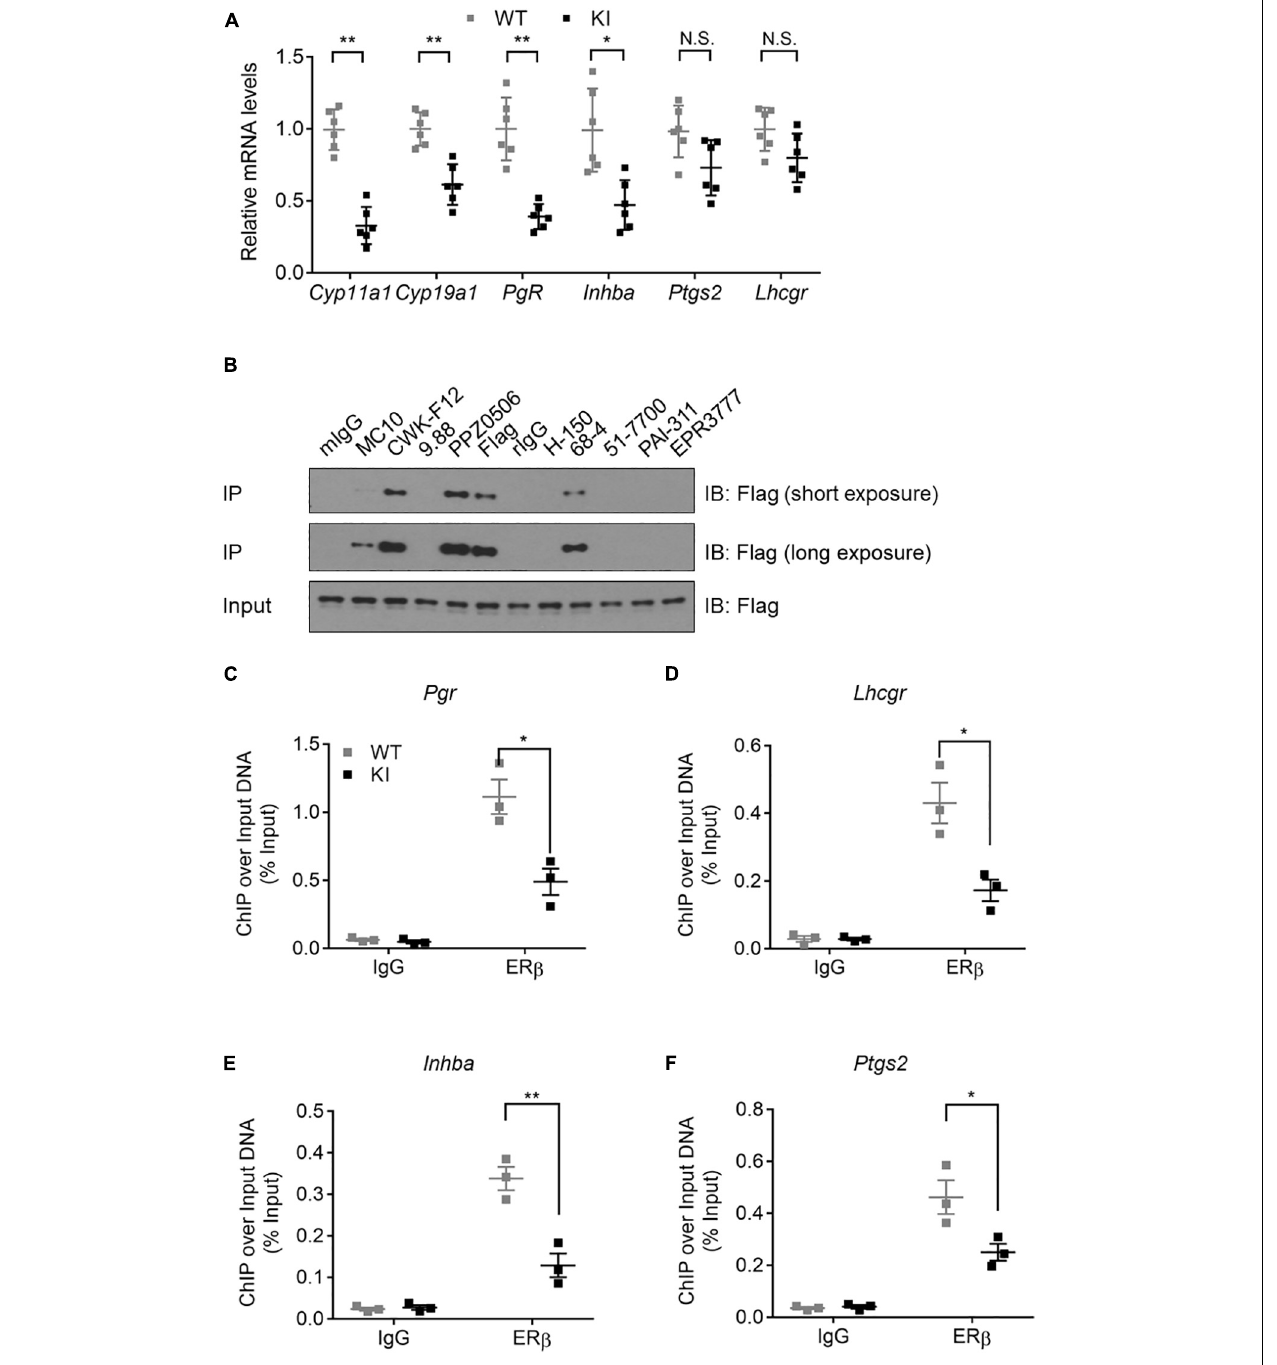
FIGURE 3 | Y55 is important for ER β transcriptional activity in murine ovaries. (A) Levels of mRNA for steroidogenesis genes in the ovaries from WT and KI mice ( n = 6) after superovulation. N.S.: Not Significant, ** p < 0.01, * p < 0.05, and Student’s t -test. (B) IP-WB of 293T/Flag-mER β cells with a panel of commercial anti-ER β antibodies. (C–F) ChIP-qPCR analyses of ER β occupancy near TSS of the Pgr (C) , Lhcgr (D) , Inhba (E) , and Ptgs2 (F) genes in mouse ovaries from WT and KI mice. ** p < 0.01, * p < 0.05, and Student’s t